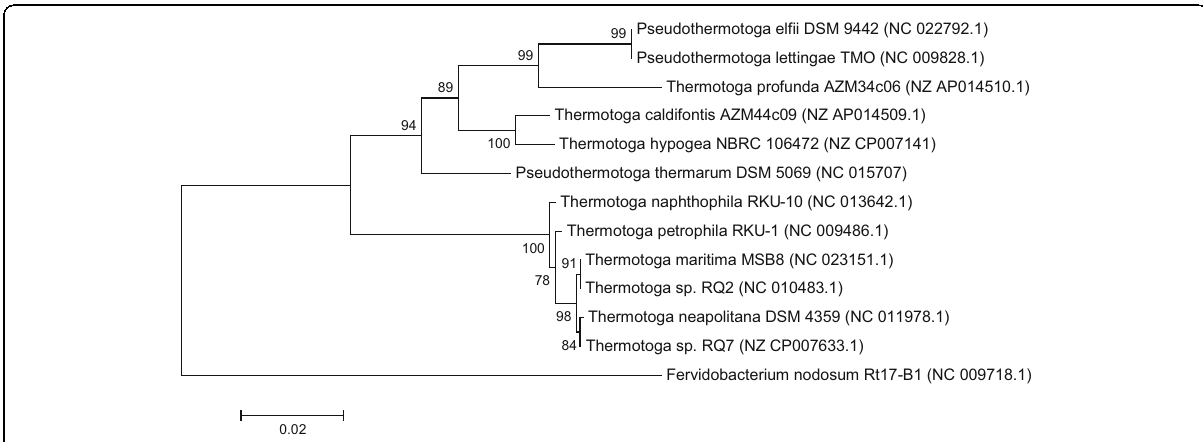
Fig. 1 Phylogenetic tree showing the position of T. sp. strain RQ7 relative to other species within the order Thermotogales . Only species with complete genome sequences are included. The tree was built with 16S rRNA gene sequences, using the Neighbor-Joining method with MEGA7 [50]. Fervidobacterium nodosum serves as the